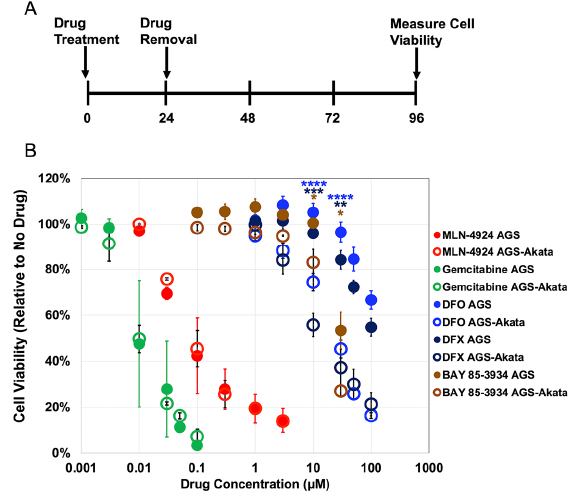
Figure 3. Cell viability of EBV(+) AGS-Akata versus EBV(-) AGS cells following incubation with a variety of hypoxia mimics versus gemcitabine. ( A ) Protocol used for treating cells for 24 h with the indicated agents followed by assaying for cell viability at 96 h. ( B ) Effects of various dosages of gemcitabine (green), MLN-4924 (red), DFO (blue), DFX (navy), and BAY 85-3934 (brown) on cell viability of AGS (closed circles) and AGS-Akata (open circles). Error bars indicate ± S.E.M.; n = 3–9; p -values for EBV-positive cells compared to AGS cells: *, p ≤ 0.05; **, p ≤ 0.005; ***, p ≤ 5 × 10 − 4 ; ****, p ≤ 5 × 10 − 5